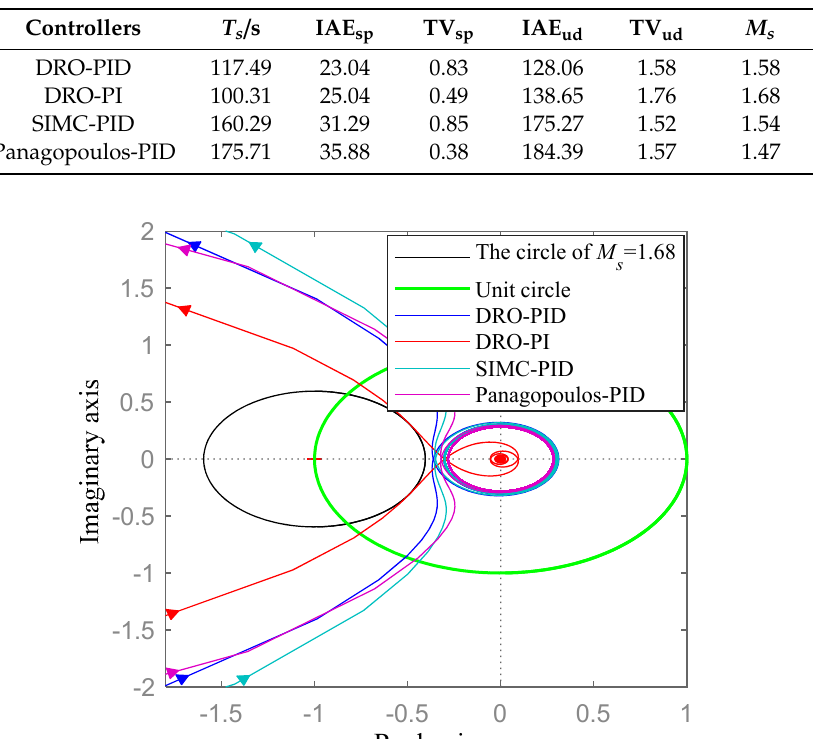
Figure 14. The Nyquist diagram for Example 3 with different controllers.